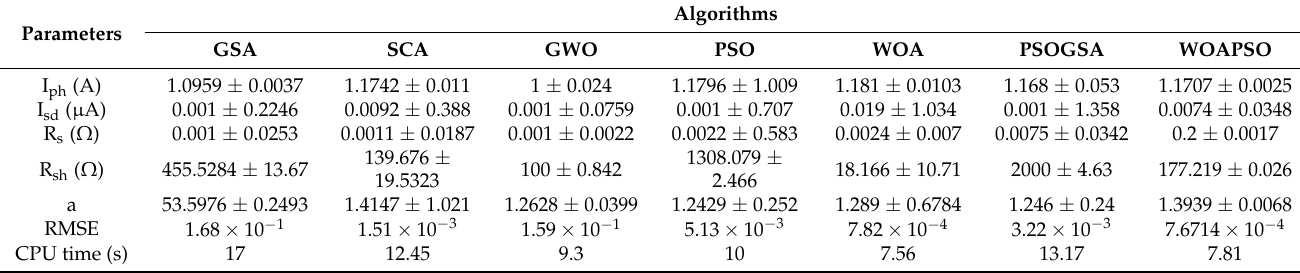
Table 4. Comparison of proposed WOAPSO with different parameter estimation methods for SS2018P PV module (1000 W/m 2 ).